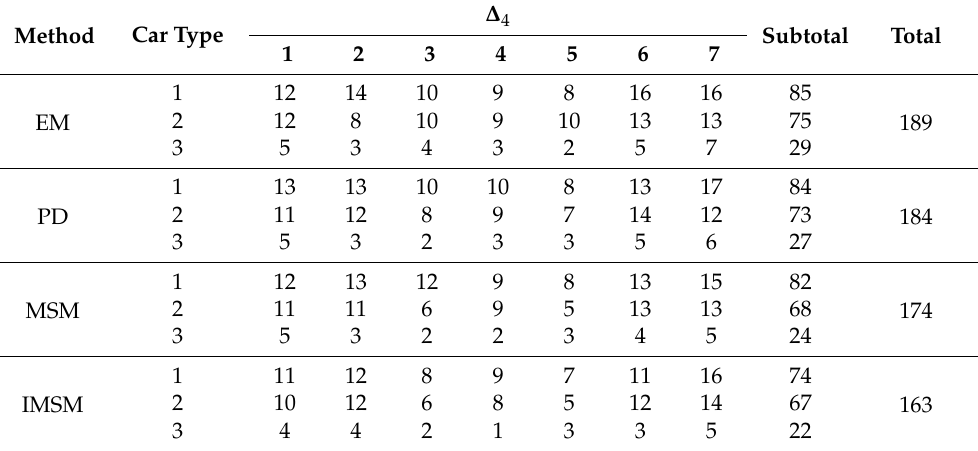
Table 11. Hybrid forecasting results based on different estimation methods.